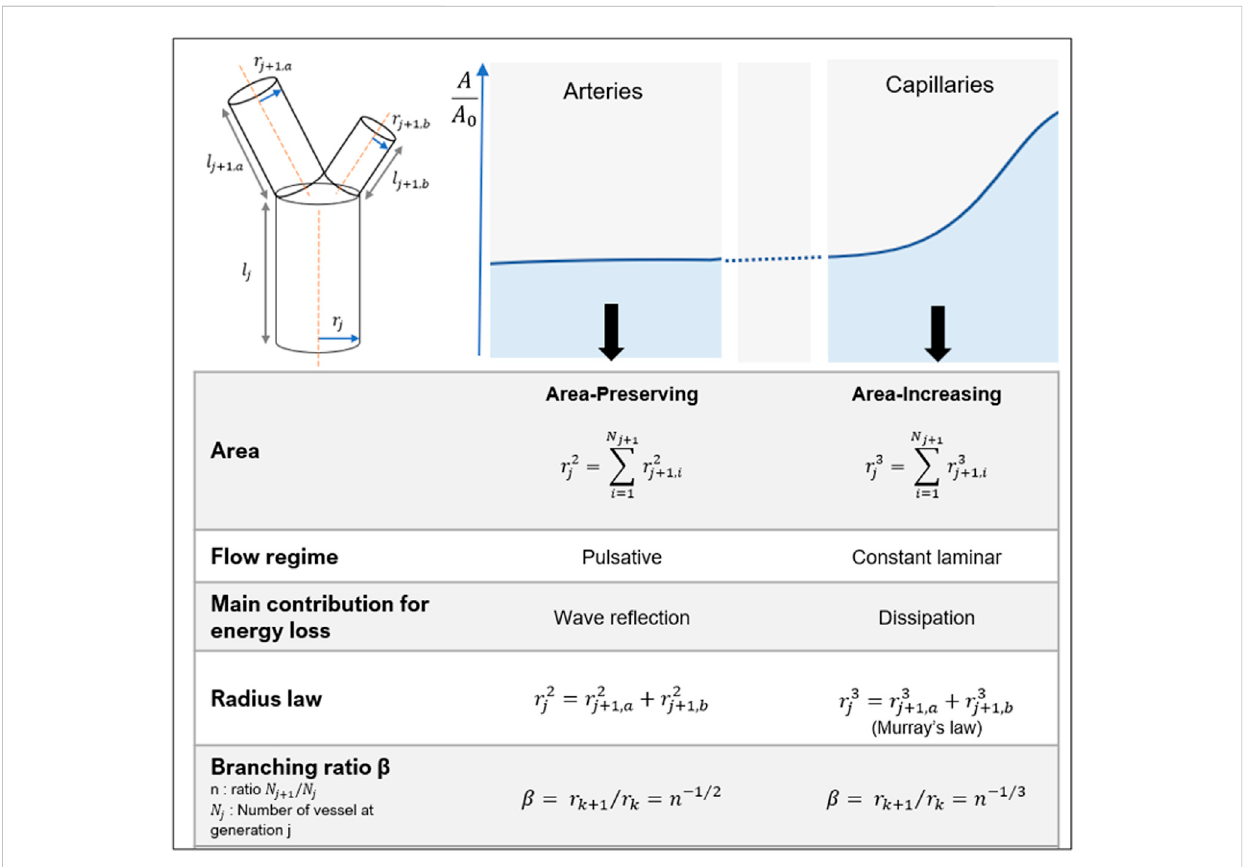
Biologicalallometriesrelatedtovascularbranching.Inlargestvesselssuchasarteries,thepulsative fl owisdominant,area-preservingprincipleallow to minimise wave re fl ections phenomena. The branching ratio exponent can vary but remains around ½ whether the bifurcations is symmetric or asymmetric. For smallest vessels such as capillaries, the viscous forces are crucial, and the network follow an area-increasing behaviour. Murray ’ s law is recovered in such